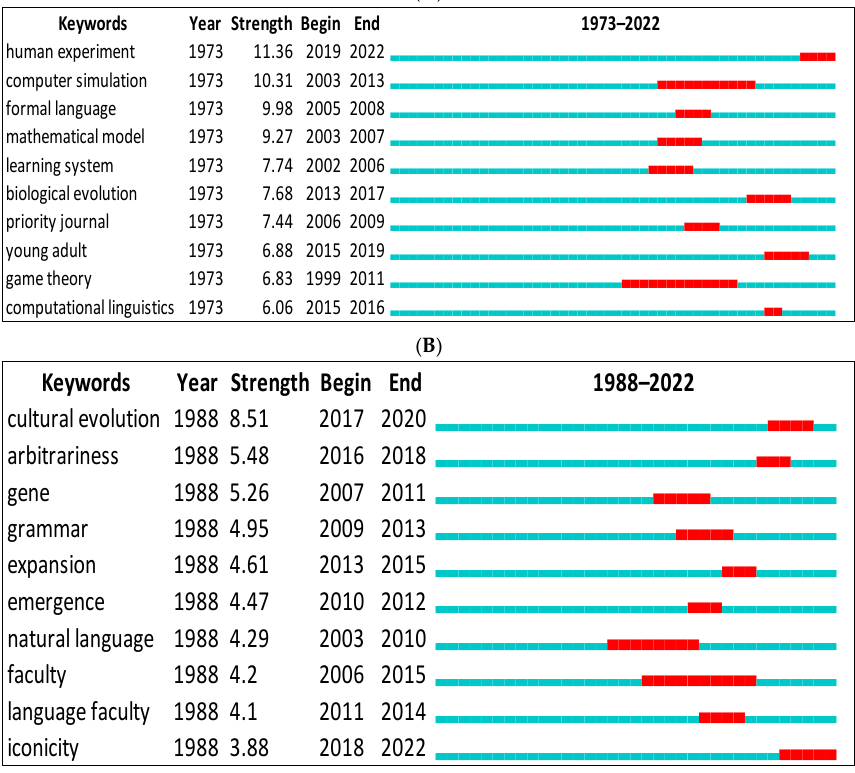
Figure 8. Top 10 keywords with the strongest citation bursts. ( A ) (Scopus), ( B ) (WOS).